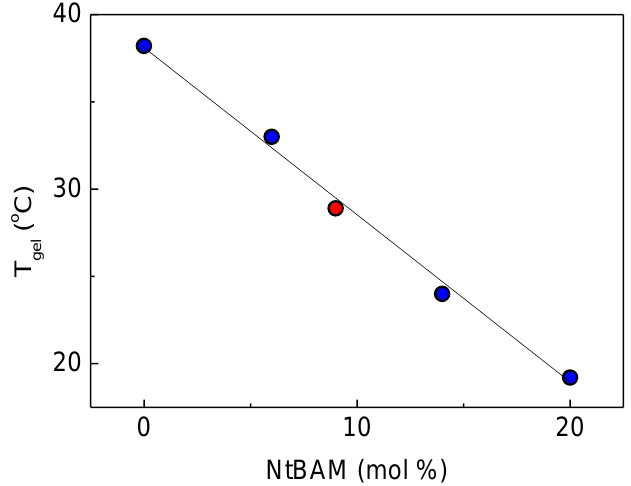
Figure 4. T gel as a function of the overall NtBAM content. The blue data have been taken from [36] and the red one concerns the ALG/HGC. The line is the linear regression of the data.